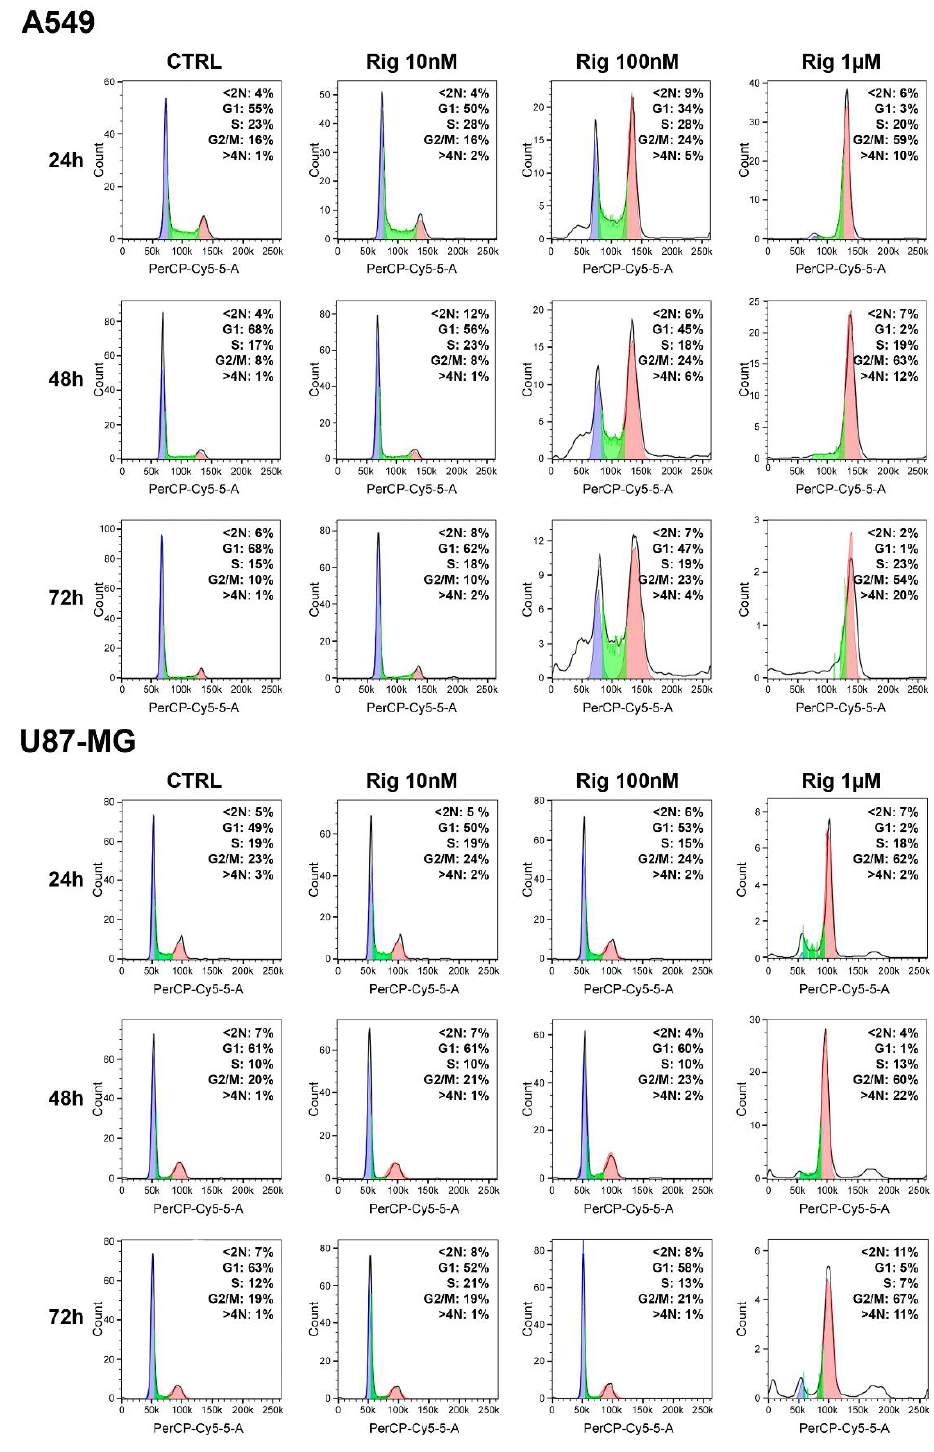
Figure 5. Cell cycle analysis of A549 and U87-MG cells after Rig treatment. Images are representative of cell cycle analysis of A549 and U87-MG, not treated (CTRL) or treated with increasing concentra- tions of Rig (10 nM, 100 nM, and 1 µ M) for 24, 48, and 72 h. Blue, green and red colors represent cells in G1, S and G2/M respectively. The percentage of cell distribution in the different phases of cell cycle represented the average of at least three independent